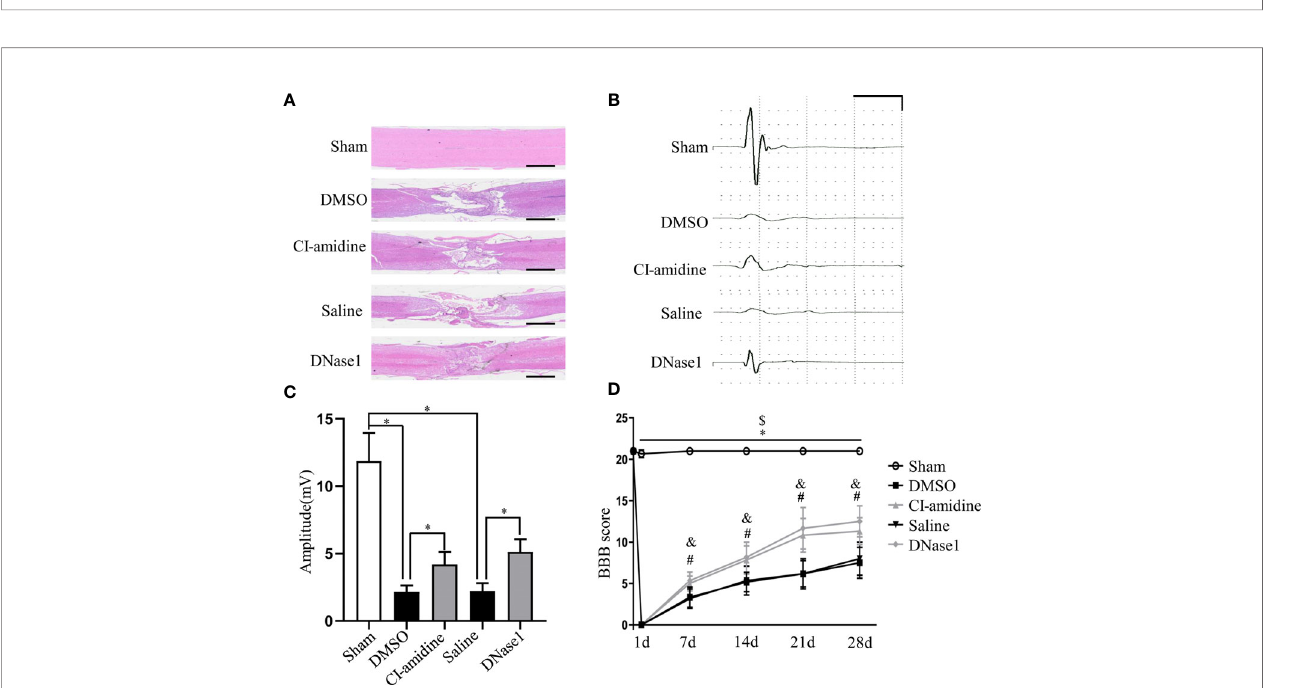
FIGURE 7 | Restricting NETs reduces tissue damage and promotes motor function recovery after SCI. (A) Representative images of H&E staining performed on the injured spinal cord section of each group at 28 days after operation. Scale bars = 2 mm. (B) Representative recording of motor evoked potentials (MEPs) of each group at 28 days after operation. Scale: 5 mV/10 ms. (C) Amplitudes of MEPs of each group. Data are presented as means ± SD of n = 6 (* p < 0.05 versus vehicle). (D) The BBB scores at different time points of each group. Data are presented as means ± SD of n = 6 (* p < 0.05 sham versus DMSO, $ p < 0.05 sham versus Saline, p < 0.05 CI-amidine versus DMSO, & p < 0.05 DNase1 versus